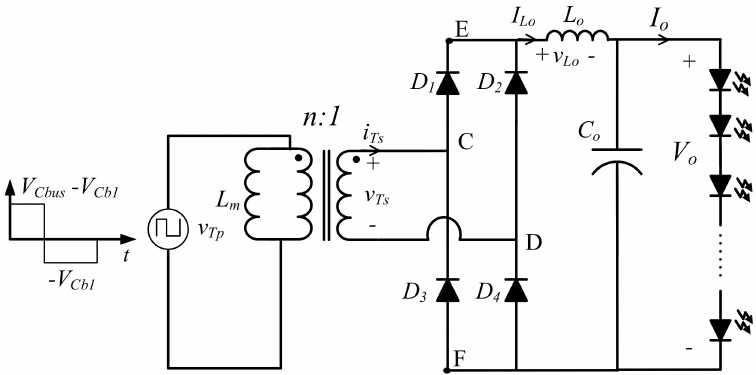
Figure 4. The simplified circuit of the proposed asymmetrical half-bridge